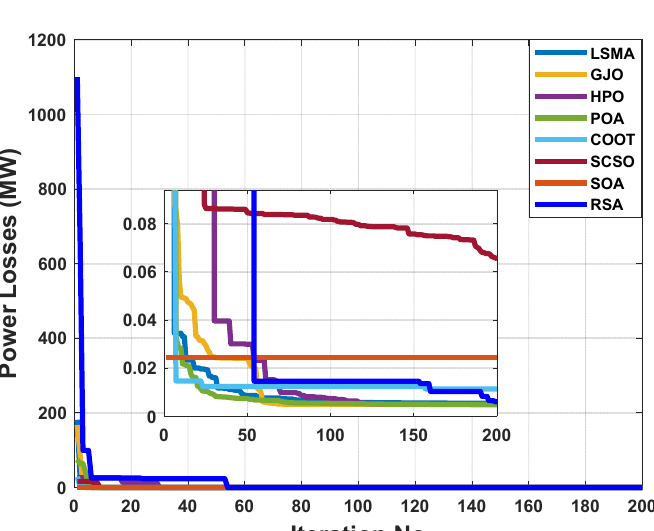
Figure 6. The convergence characteristics of POA and other compared algorithms for case 2 in a standard IEEE 14-bus test system.